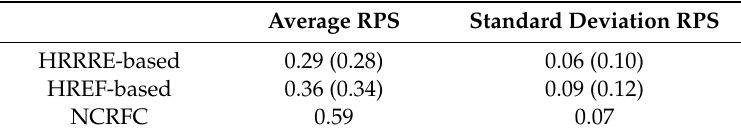
Table 4. Averages and standard deviations for rank probability scores (RPSs) for HRRRE, HREF, and NCRFC ensemble streamflow predictions for the seven shared (all 11) basins.